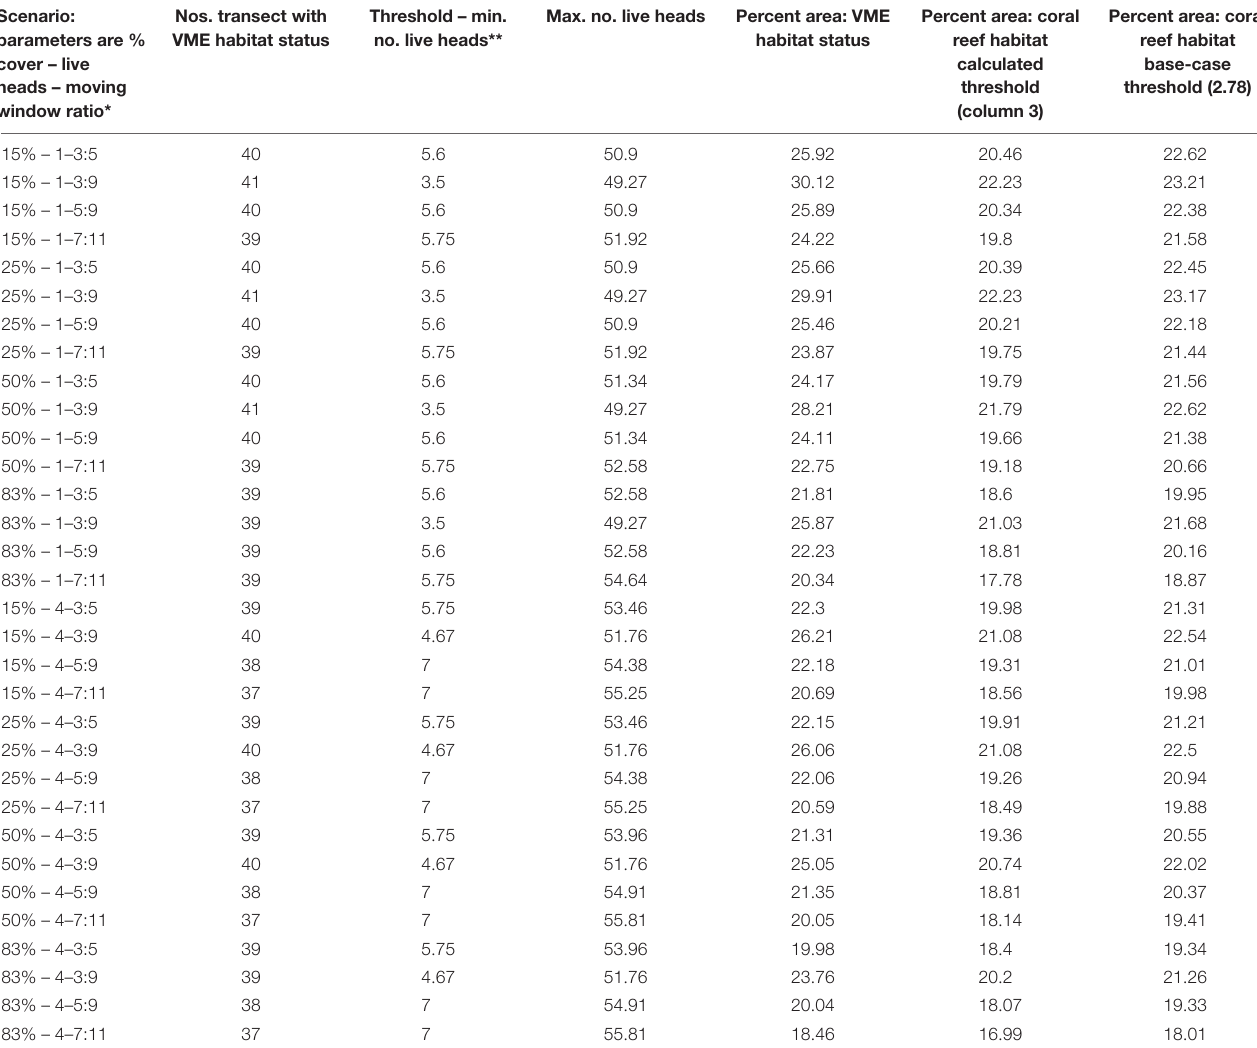
TABLE 2 | Summary outputs from modeling scenarios used to classify habitats as having VME status; key parameters (column 1) are varied in order to test the sensitivity of the